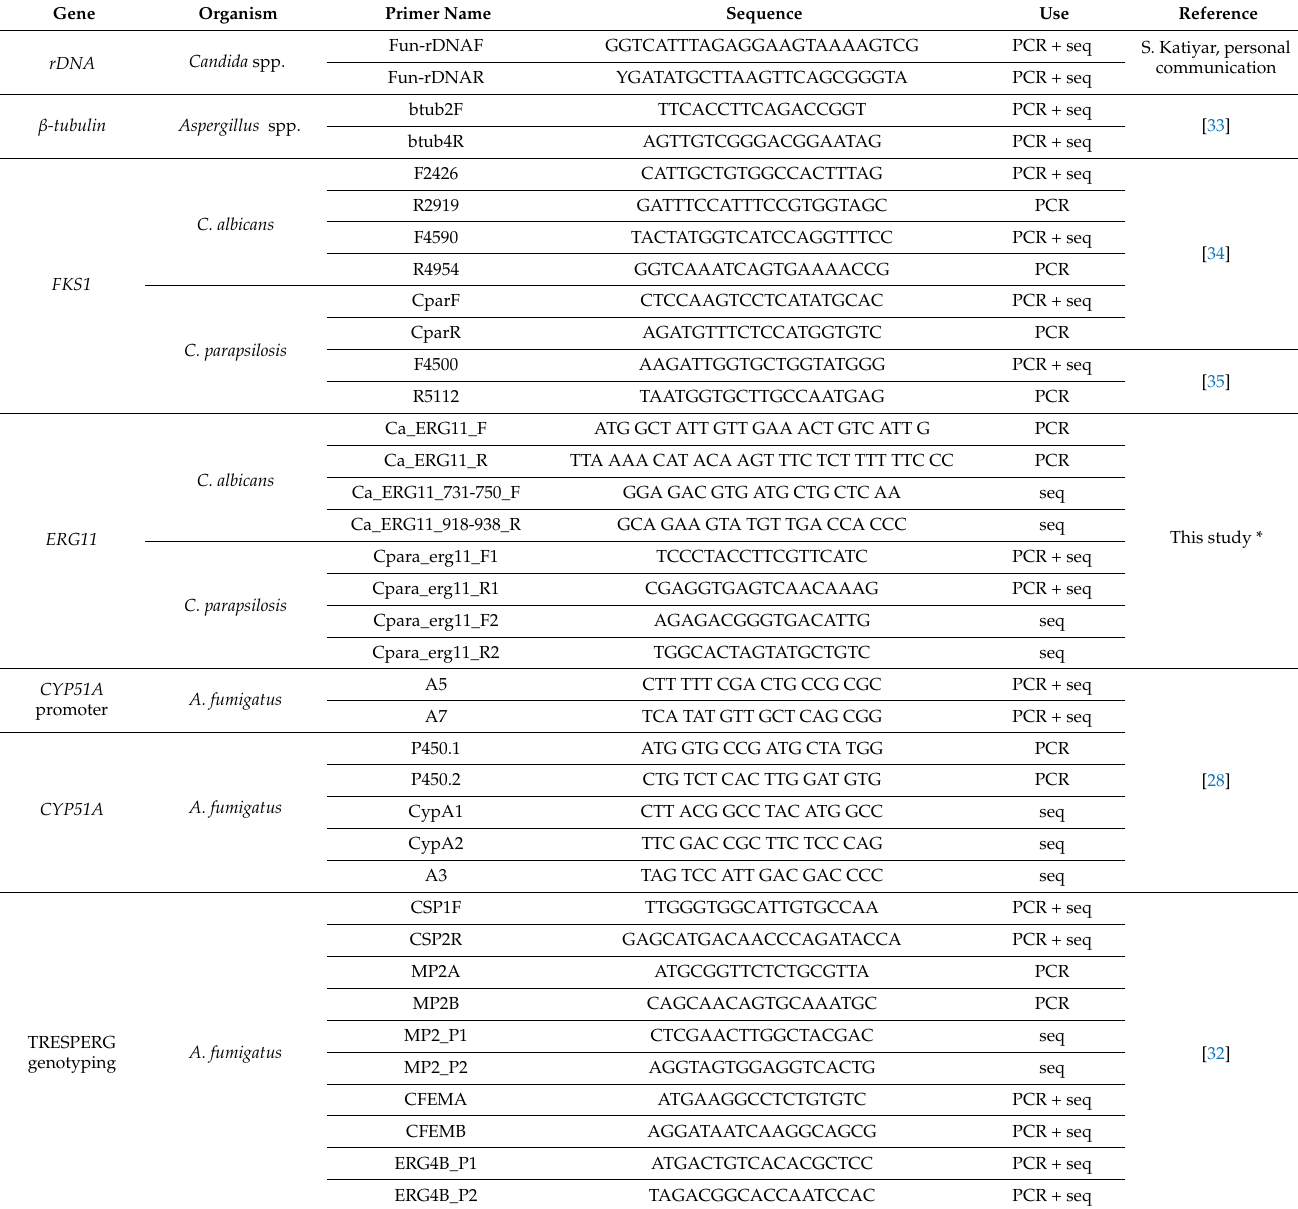
Table 2. Primers used in the